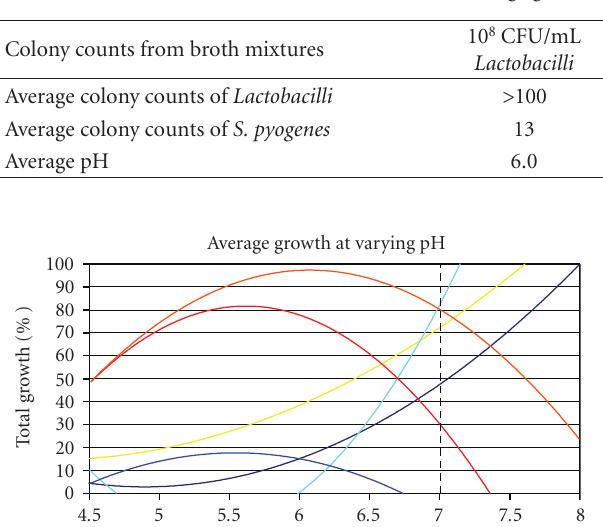
Table 1: Average growth and pH of the broth mixtures.